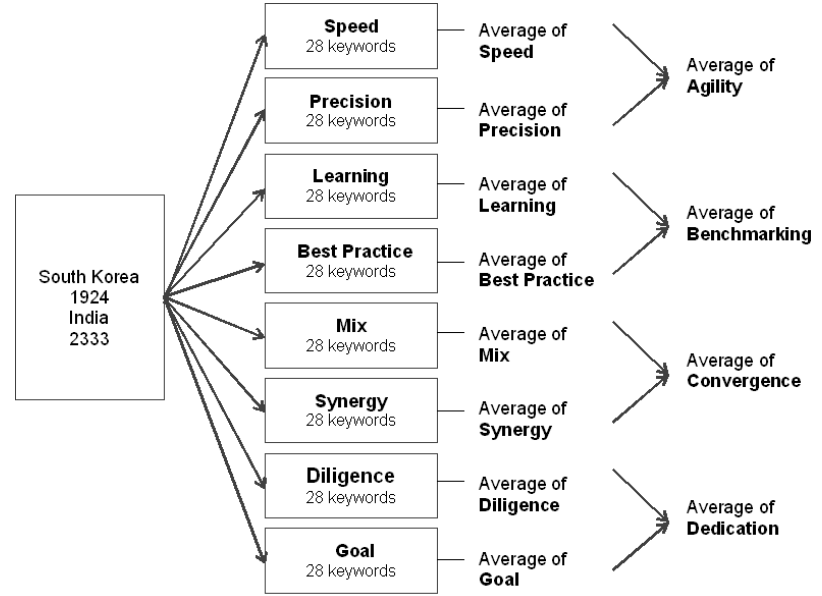
Figure 2. The process of calculating similarity scores for sub-categories.